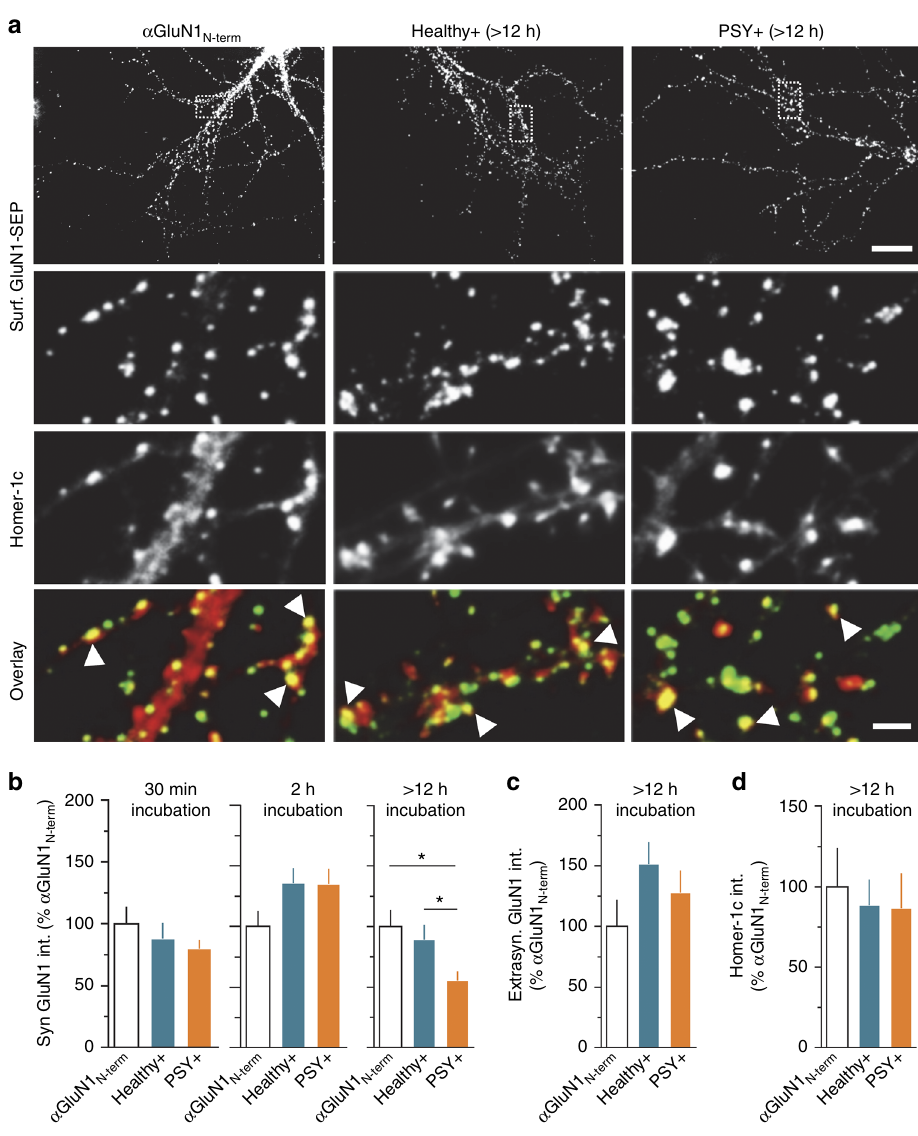
Fig. 5 PSY + NMDAR-Ab speci fi cally alter NMDAR synaptic content in a time-dependent manner. a Live staining of GluN1-SEP in hippocampal cultures treated overnight with either a control antibody ( α GluN1 N-term ) or human puri fi ed IgG (Healthy + or PSY + NMDAR-Ab). The synaptic localization of NMDAR clusters (green) was determined using Homer-1c (red). Colocalized staining was interpreted as synaptic GluN1-NMDAR clusters (white arrowheads). Three out of three Healthy + and four out of nine PSY + samples were used and pooled for comparisons. Scale bar, 20 µ m (upper panels), 2 µ m (lower panels). b Normalized synaptic GluN1-NMDAR fl uorescence intensity (normalization to the control condition α GluN1 N-term ) after incubation with α GluN1 N-term ( n = 19 neurons), Healthy + ( n = 36), or PSY + ( n = 55) for 30 min ( P = 0.7604, one-way ANOVA); after incubation with α GluN1 N-term ( n = 24), Healthy + ( n = 47) or PSY + ( n = 77) for 2 h ( P = 1.389, one-way ANOVA), or after incubation with α GluN1 n = 22), Healthy + ( n = 34) or PSY N-term ( + ( n = 28) for 12 h. Synaptic NMDAR fl uorescence intensity is reduced after a 12 h exposure to PSY + NMDAR-Ab (* P < 0.05, one-way ANOVA followed by Tukey ’ s multiple comparison test). c Normalized extrasynaptic GluN1-NMDAR fl uorescence intensity after 12 h incubation with α GluN1 N-term ( n = 14 neurons ) , Healthy + ( n = 34), or PSY + ( n = 30) NMDAR-Ab ( P = 0.2385, Kruskal – Wallis test). d Normalized Homer-1c fl uorescence intensity after a 12